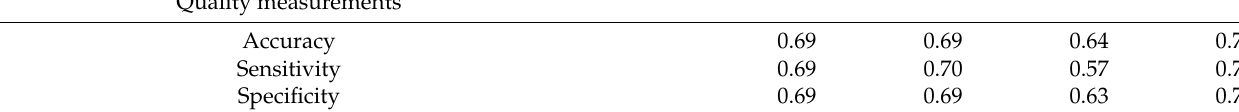
Table 5. Results from logistic mixed regression analysis for the detection of BCoV 1 in nasopharyngeal swab samples in 33 Swiss veal calf farms regarding group size 2 and age 3 , as well as the interaction between group size and age. Additionally, the regression slope 4 for group size is provided for each age class separately.